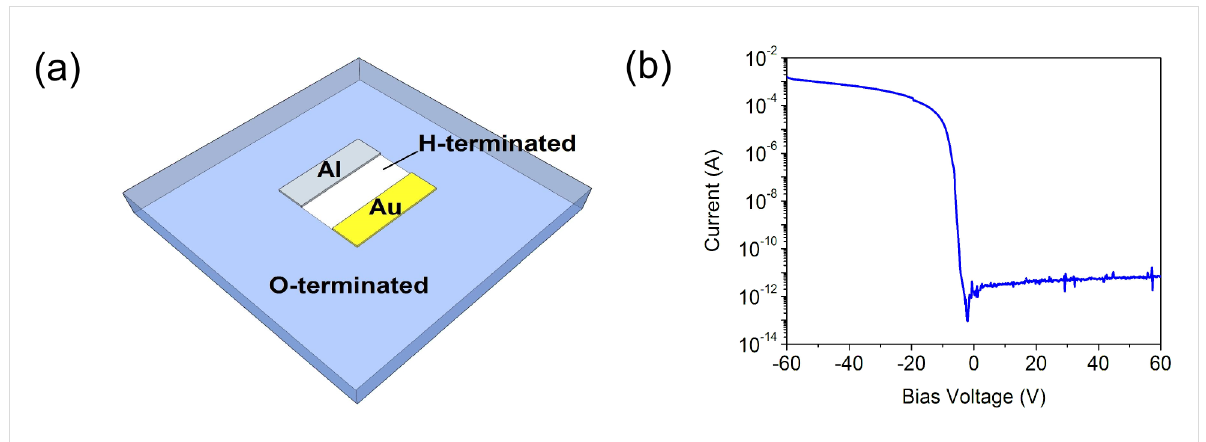
Figure 3: Active charge state control of a single NV centre. At zero bias there is only a PL-background of the diamond surface (black spectrum) since the NV centre is in the nonfluorescent NV + state due to the interaction with the two-dimensional hole accumulation layer. Upon applying a reverse bias potential of +15 V, we detect a spectrum of NV 0 emission (red spectrum). Upon applying a higher reverse bias potential (+20 V) we detect a spectrum of NV − emission (blue spec-